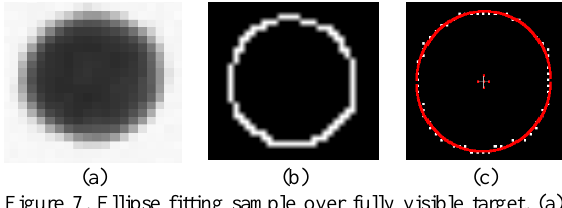
Figure 7. Ellipse fitting sample over fully visible target, (a) source image, (b) target edge pixels and (c) the fitted